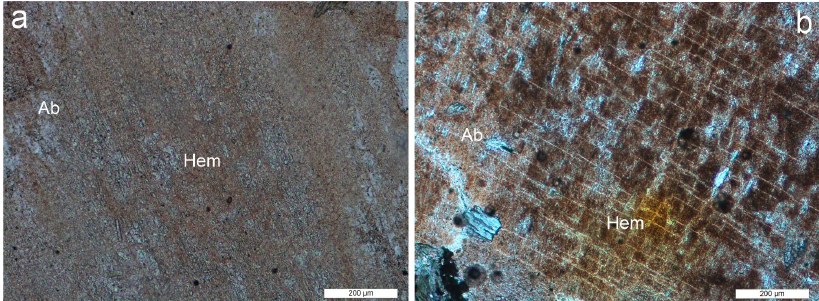
Figure 7. Microphotographs of hematitized albite (Ab—albite and Hem—hematite), ( a )—very fine hematite grains uniformly distributed in albite, sample R-707, Nahošín uranium deposit, ( b )—hematite aggregates irregularly distributed in albite, sample R-784, Me č ichov uranium deposit. Plane polarizers.